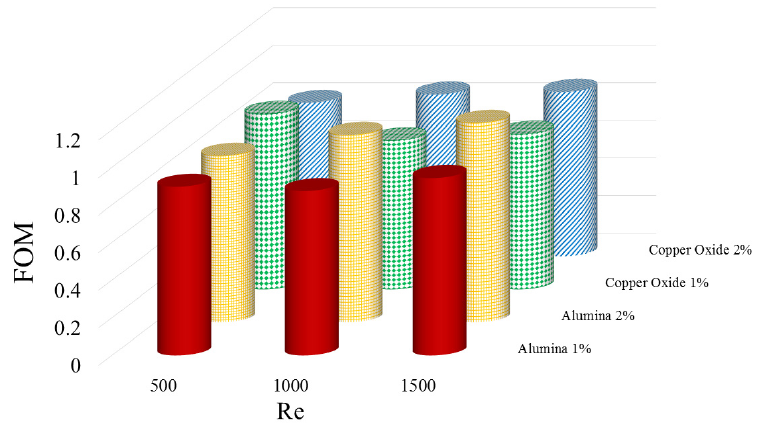
Figure 11. FOM for 1 vol and 2 vol% 𝐴𝑙 (cid:2870) 𝑂 (cid:2871) and 𝐶𝑢𝑂 NFs at 𝑅𝑒 = 500, 1000, 𝑎𝑛𝑑 1500 .